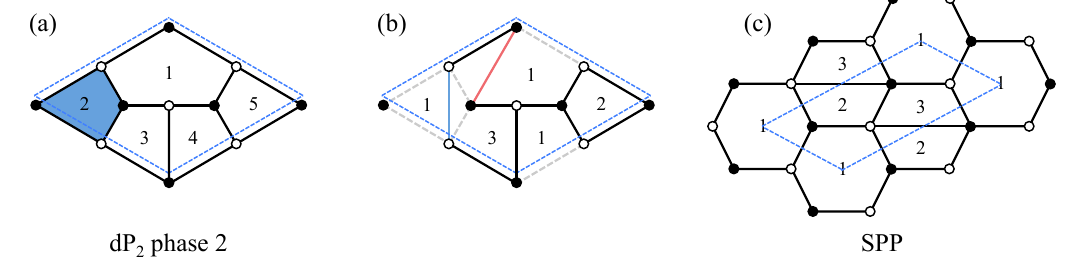
Figure 47. Instanton backreaction from phase 2 of dP 2 to